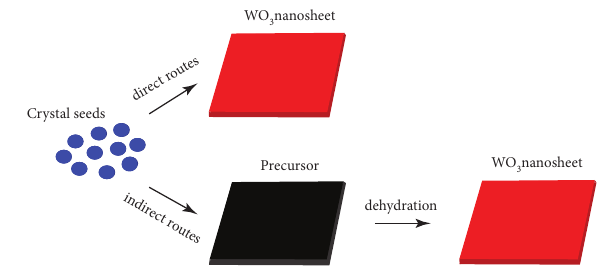
Figure 4: Direct and indirect synthesis route for 2D WO3